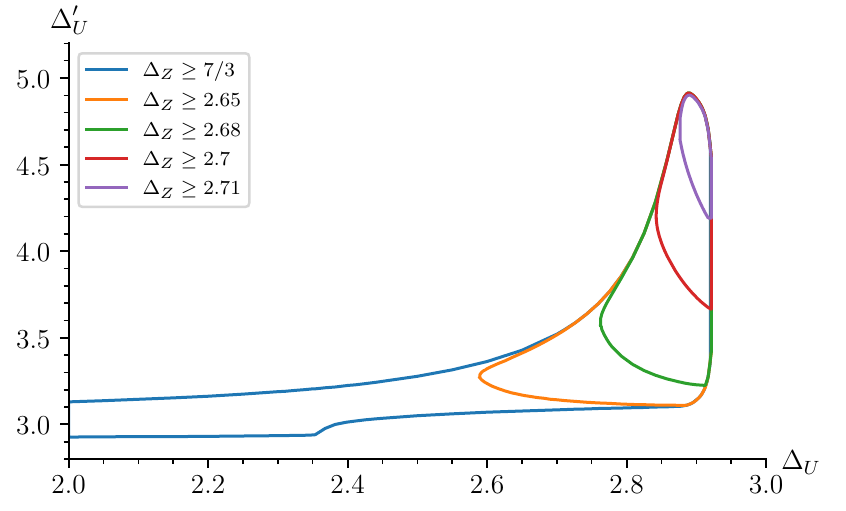
Figure 8 . Allowed values of ∆ U versus ∆ 0 , the dimensions of the first two multiplets in the ϕ × ¯ ϕ U and M × M OPEs, as a function of the gap ∆ Z in the channel ϕ × M . We assume that these are the only two operators below ∆ 00 ≥ 6 , that the short multiplet ϕM is missing, and the parameters ∆ ϕ , U c and k are fixed to the values of the rank-one H 1 theory. The allowed region is enclosed between the upper and lower curves. The numerical optimization is using Λ = 24